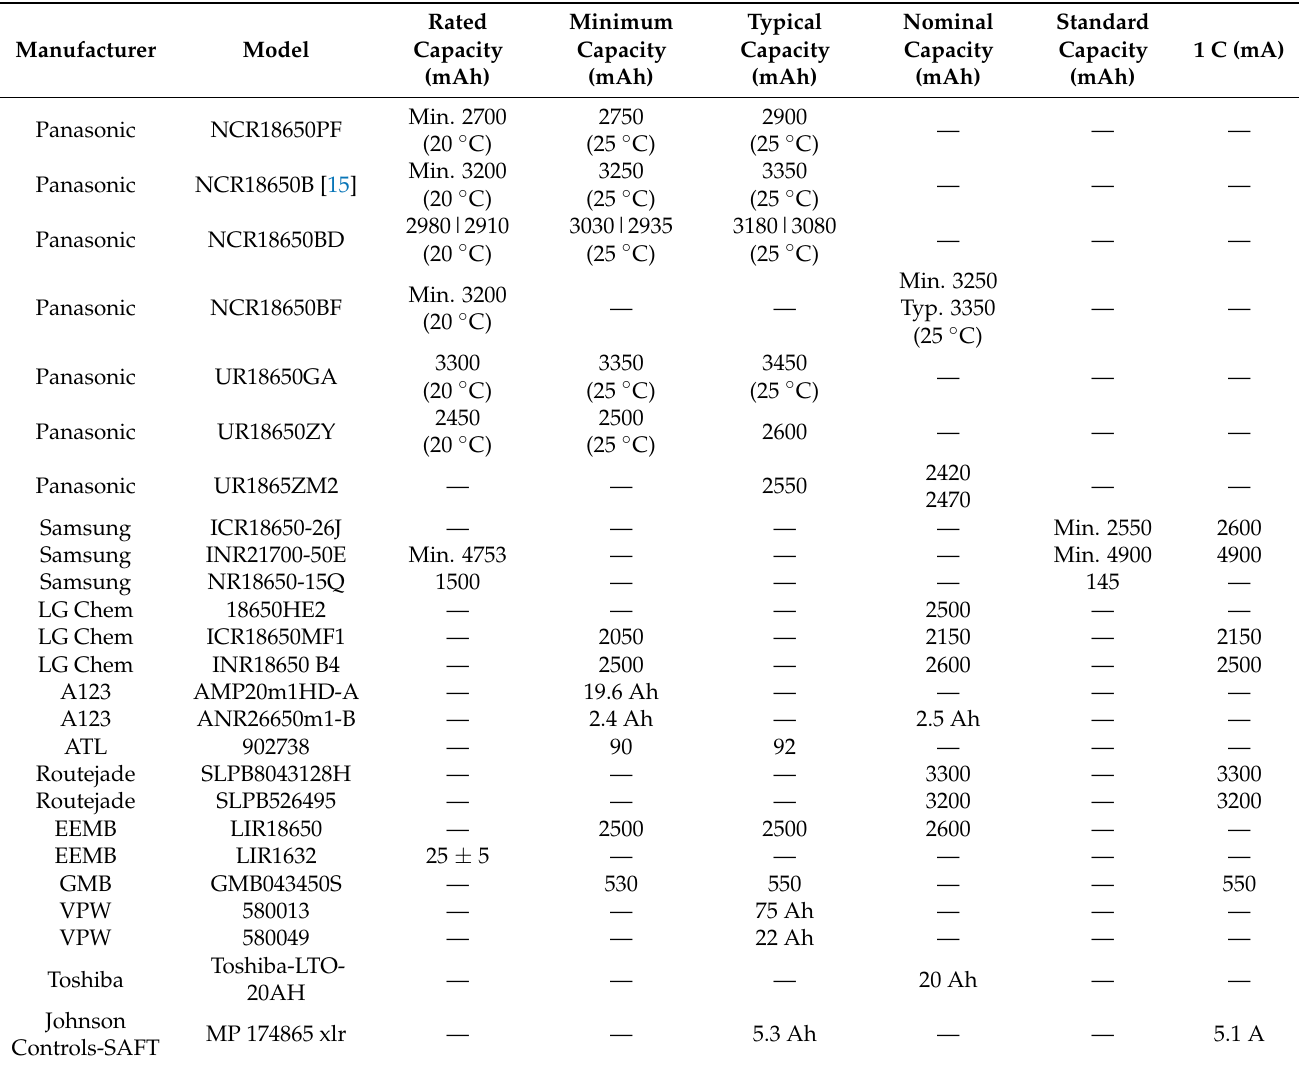
Table 2. Capacity terms used in